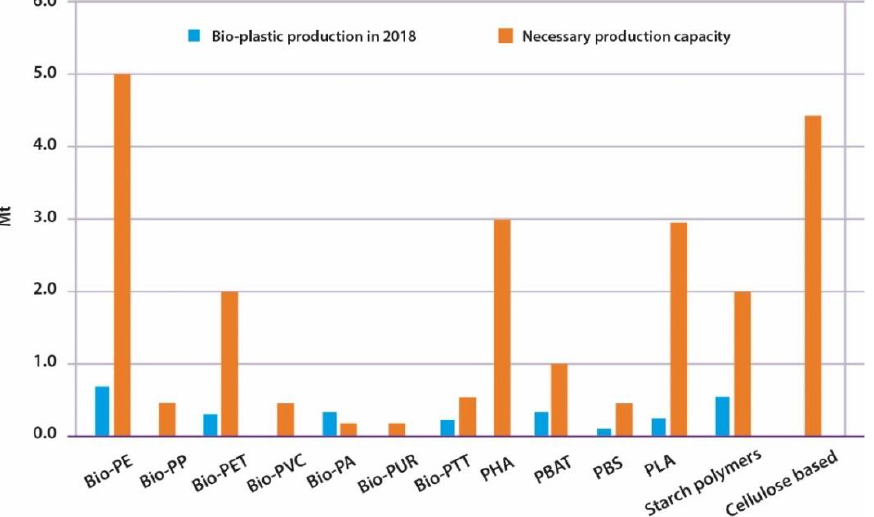
Figure 20. Current Bioplastic Packaging Production versus Necessary Production Capacity Source. Adapted from “The Unintended Side Effects of Bioplastics: Carbon, Land, and Water Footprints” , One Earth, vol. 3, no. 1. Cell Press, pp. 45 – 53, Jul. 24, 2020. doi: 10.1016/j.oneear.2020.06.016 [77].